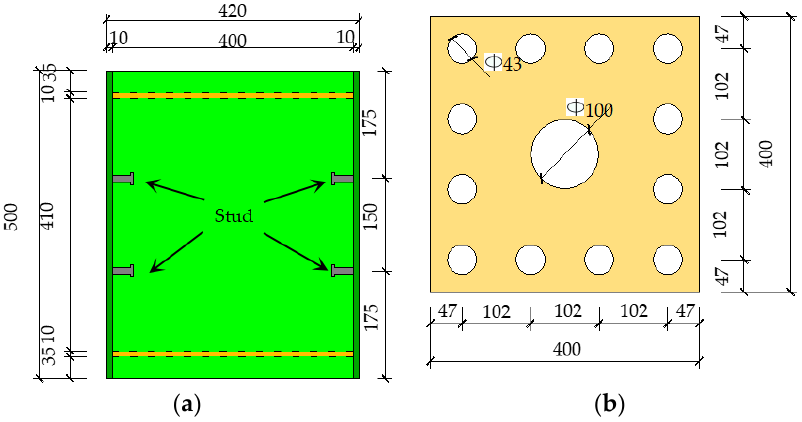
Figure 5. ( a ) Front view of the steel sleeve in the joint core area; ( b ) vertical view of the steel sleeve in the joint core area (unit: mm).